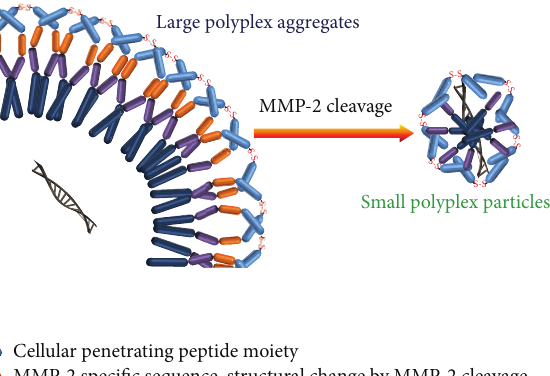
Scheme 1: A scheme for the proposed mechanism of structural change of MPD polyplex in the presence of MMP-2.